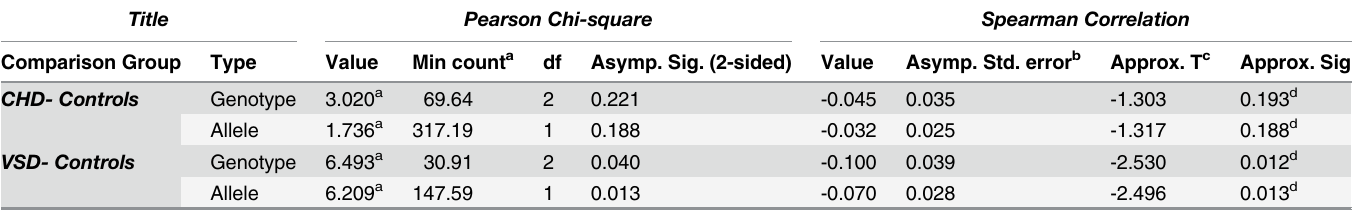
Table 3. SNP rs2289263 before 5 ’ UTR of SMAD3 gene associated with the risk of ventricular septal defect not congenital heart diseases in Chinese